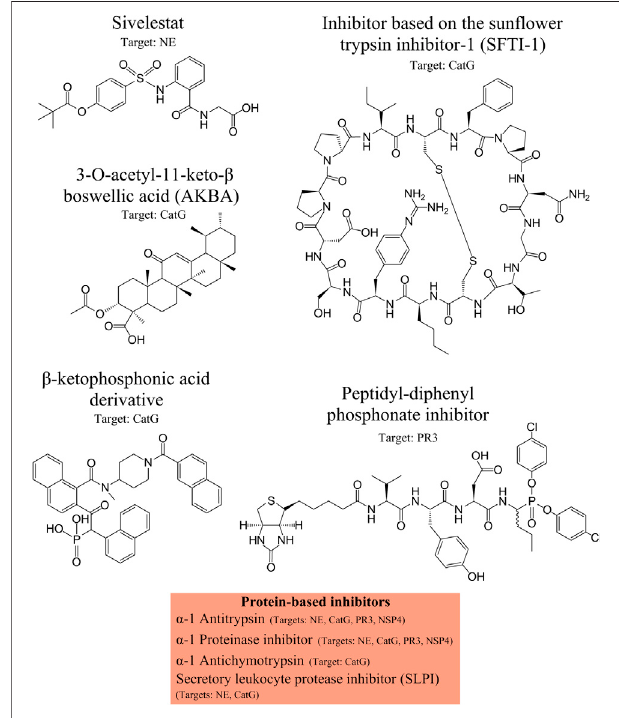
FIGURE 3 | NSPs inhibitors. Neutrophil serine protease (NSP) inhibitors with their speci fi c targets are shown from left to the right: Sivelestat, inhibitor based on the sun fl ower trypsin inhibitor-1 (SFTI-1) scaffold, 3-O-acetyl-11- keto- β boswellic acid (AKBA), β -ketophosphonic acid derivative, peptidyl-diphenyl phosphonate inhibitor, and protein-based inhibitors, including α -1 antitrypsin, α -1 proteinase inhibitor, α -1 antichymotrypsin, secretory leukocyte protease inhibitor (SLPI). The main protease targets are